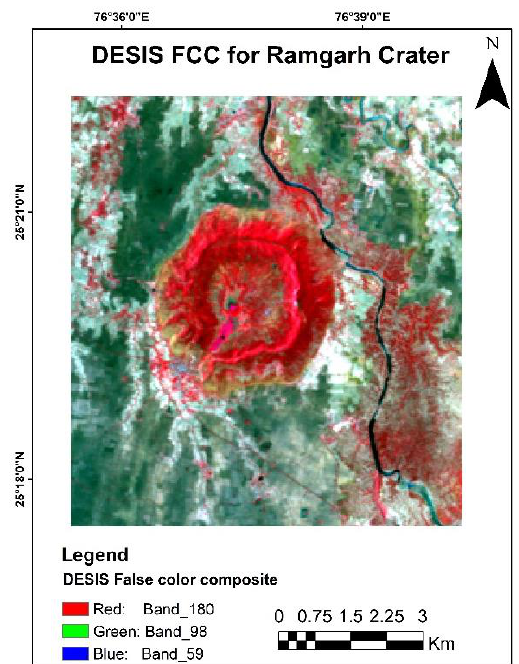
Figure 1. DESIS False-color composite RGB for Ramgarh crater in Rajasthan